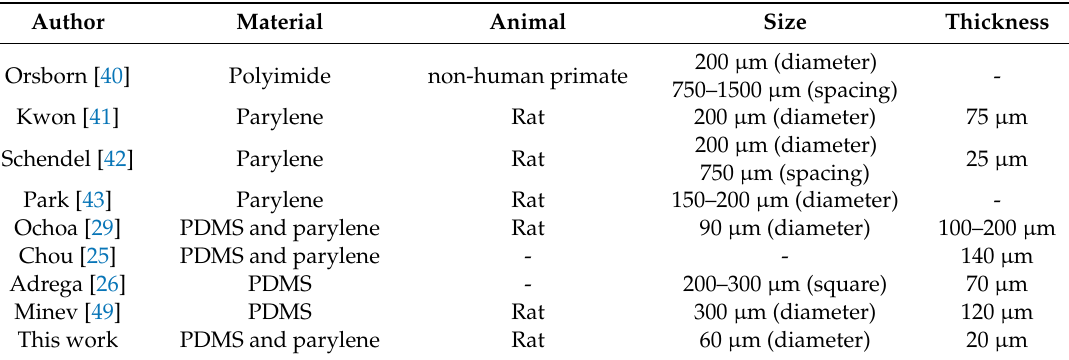
Table 1. Comparison of parameters (material, size, and thickness) in di ff erent µ ECoG